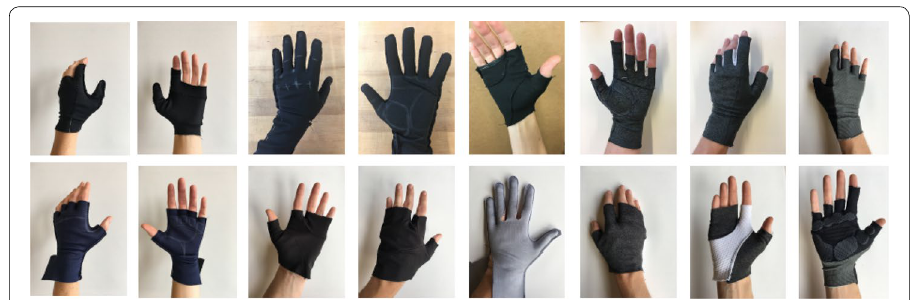
Fig. 17 Cycling glove prototypes (Sokolowski and Hoegsted 2019)